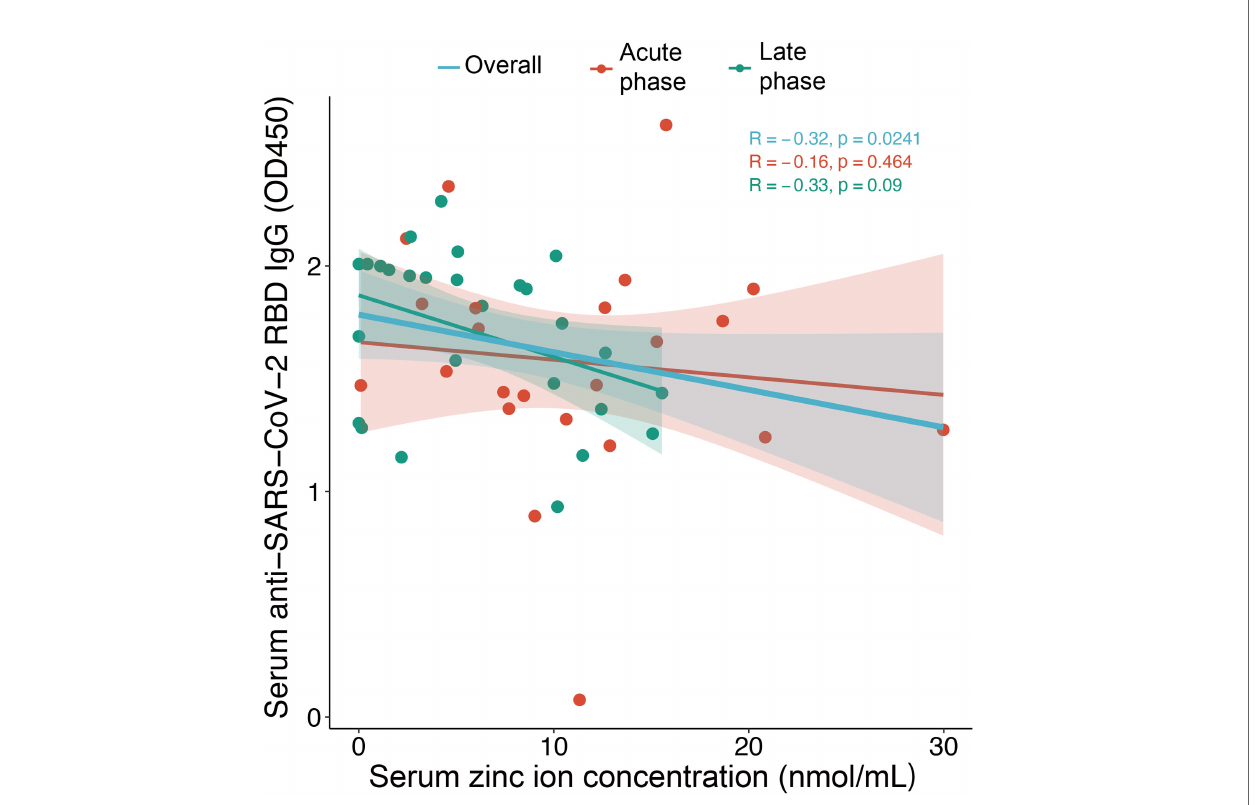
FIGURE 2 | Correlation between serum zinc ion concentrations and anti-SARS-CoV-2 RBD IgG level for samples collected in the acute phase (day 7-21) (n = 23) and the late phase (after day 21) (n=27) from COVID-19 patients. The Spearman ’ s rank-sum correlation coef fi cient and signi fi cance are shown. Shading represents 95% con fi dence intervals